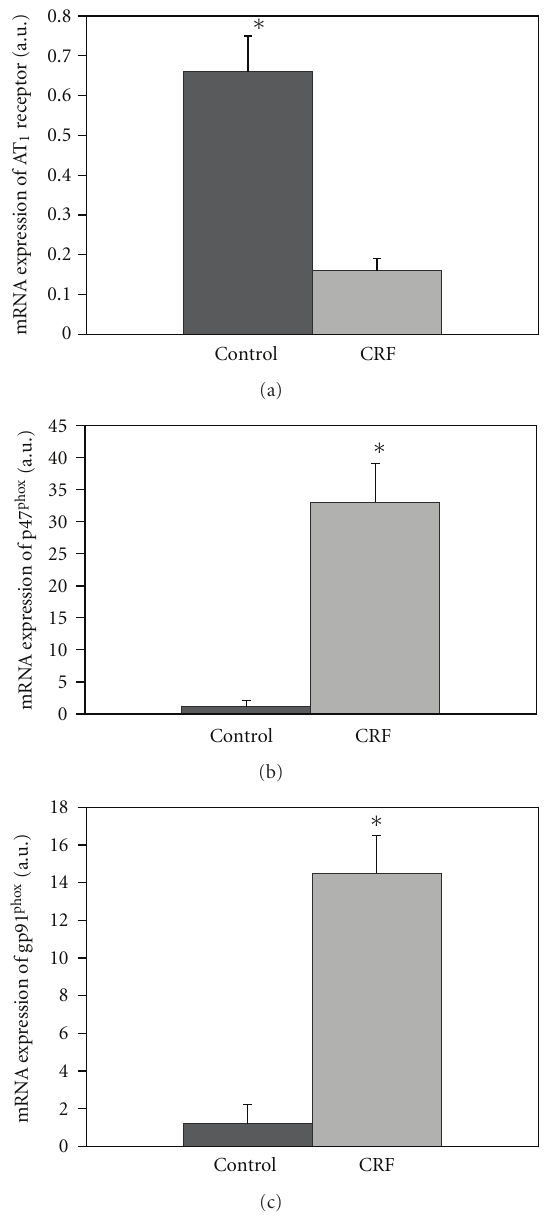
Figure 2: Relative amount of mRNA of AT 1 in the brainstem (a) and NAD(P)H subunits (p47 phox and gp91 phox ) ((b) and (c)) compared to mRNA of β -actin of C and CRF groups. ∗ P < . 05 di ff erence in relation to the C.